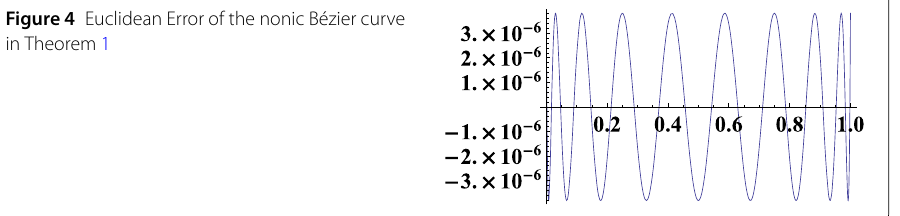
Figure 4 Euclidean Error of the nonic Bézier curve in Theorem